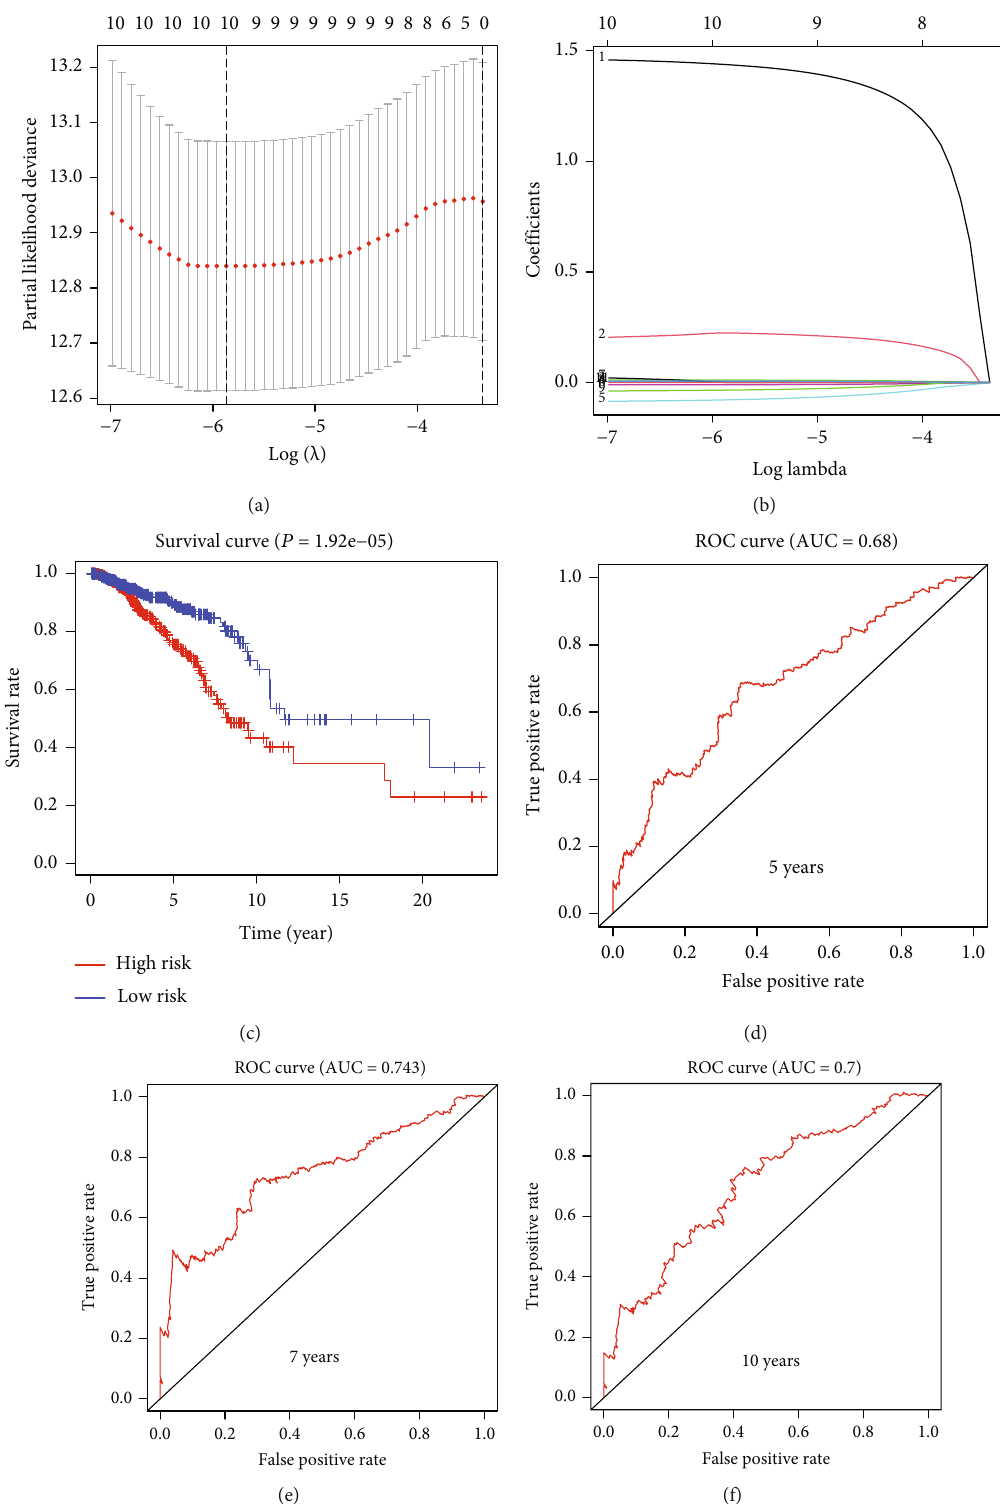
Figure 3: Construct a prognostic-related risk model in BRCA through LASSO regression analysis. (a, b) LASSO coe ffi cient values and vertical dashed lines were calculated at the best log (lambda) value, and coe ffi cients of prognostic-related genes were displayed. (c) Based on the above risk model, the K-M curve in BRCA patients showed that the overall survival rate of the low-risk group was signi fi cantly higher than that of the high-risk group ( P = 1 : 92 e − 05 ). It is worth noting that blue represents the low-risk group, and red represents the high-risk group. (d – f) ROC curves were drawn based on the risk model, and their AUC value represented the 5-, 7-, and 10-year OS of BRCA